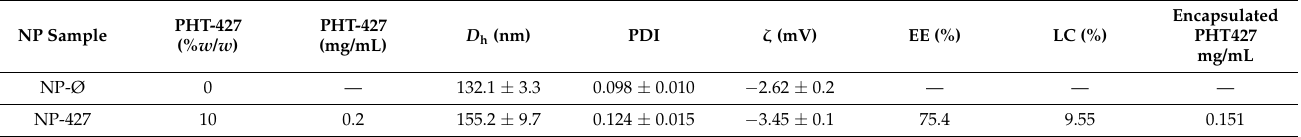
Table 1. Most relevant characteristics of NP-Ø and NP-427: hydrodynamic diameter (Dh), polydispersity index (PDI), zeta potential ( ξ ), encapsulation efficiency (EE), loading capacity (LC), and encapsulated drug concentration. Values represent mean ±